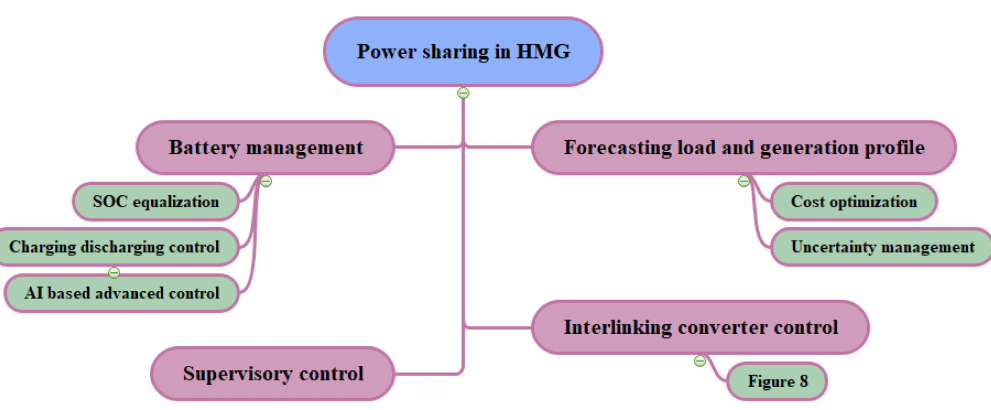
Figure 5. Load and energy management in hybrid